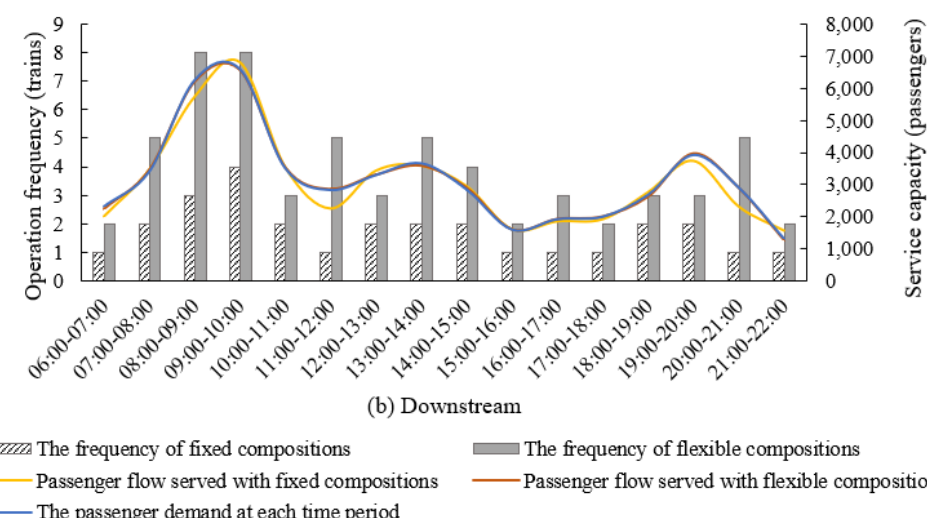
Figure 10. The operational frequency and service capacity analysis in the upstream and downstream direction when N = 140.